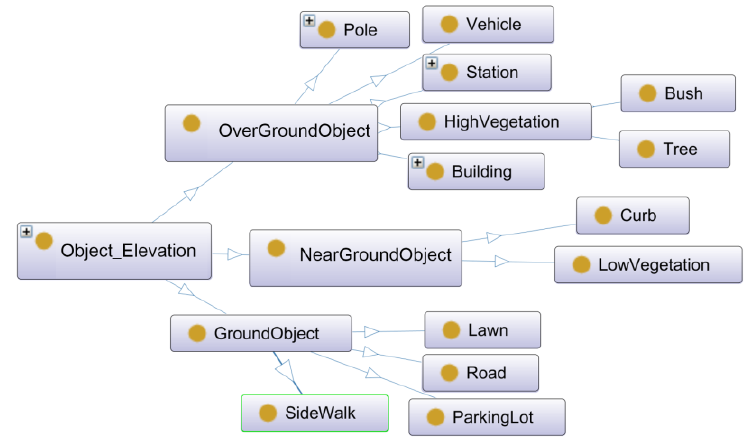
Figure 2. Classification of concepts according to the elevation perspective.